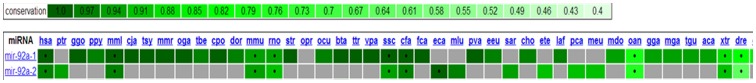
Conservational view of miR 92a in different species.According to miRbase information, miR 92a is presently denoted as miR 92a-2. This figure indicates high conservation pattern of this miR which was found to be a common hub between regulatory and co-expression network. The information regarding the conservation analysis was obtained from miRNAviewer which presents a global view of homologous miR genes in many species [34]. The colored legend indicates the conservation level of each grouped miR. Grey box indicates that the miR was not identified in this genome, under stringent parameters. Symbols • indicate miRs registered in miRbase [35].